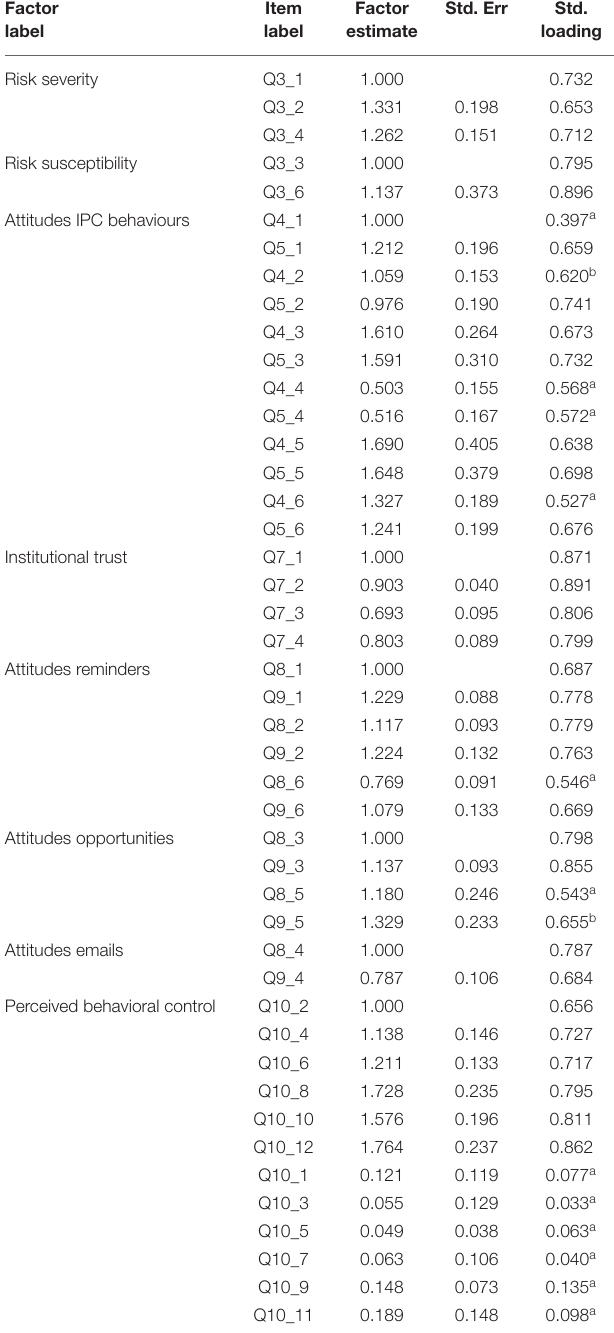
TABLE 1 | Confirmatory factor analysis. Factor